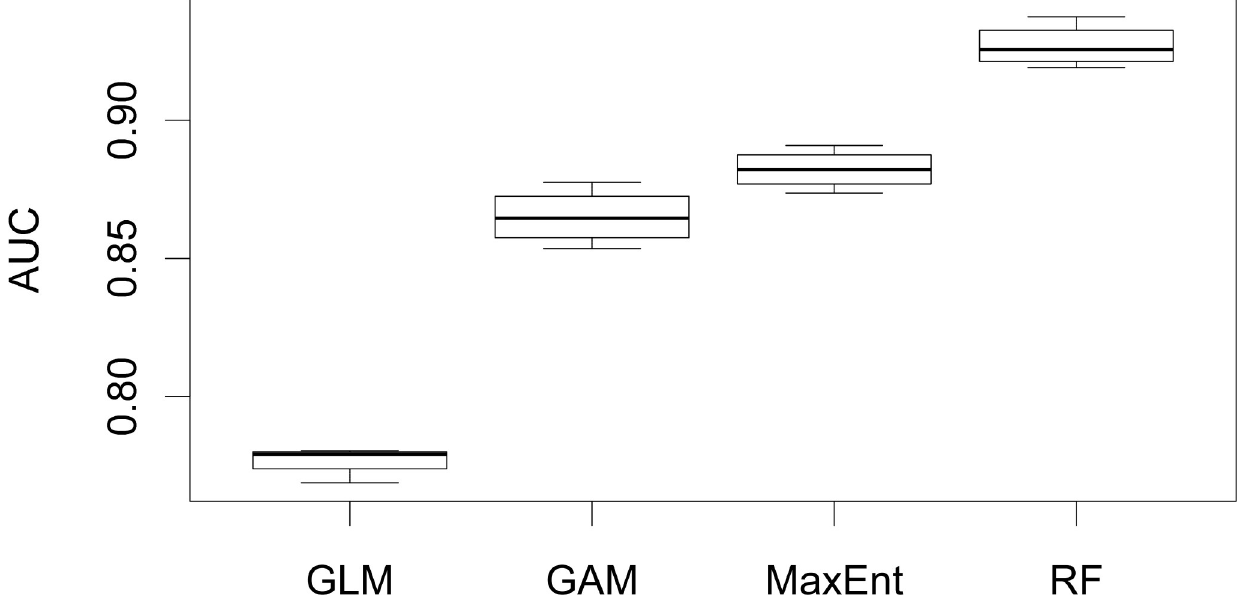
Fig 4. Results of four-fold cross-validation. In column one, we represent the four modeling approaches. Column two shows which partition of the four- fold cross validation is used. Columns three and four show the AUC and optimal threshold of each fold and column 5 shows which variable contributes most to model predictions.